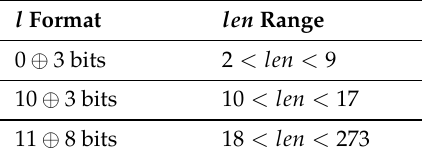
Table 5. l variable possible